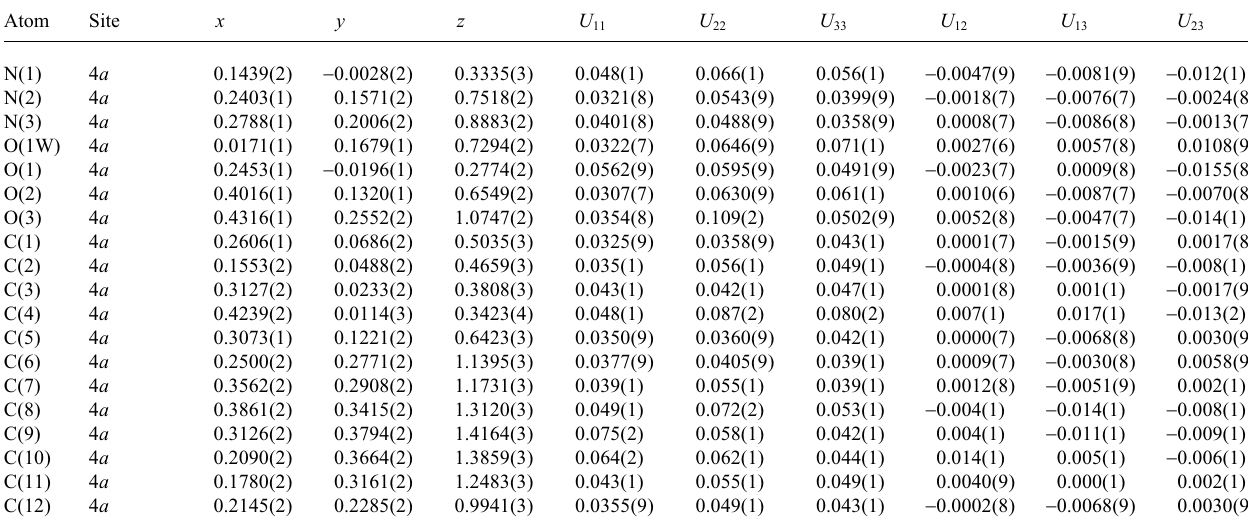
Table 3. Atomic coordinates and displacement parameters (in Å 2 )